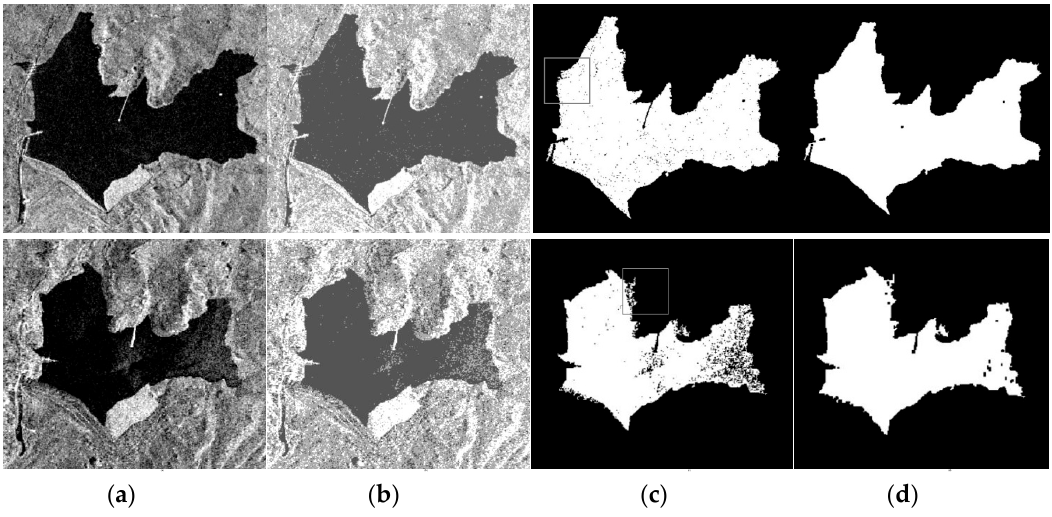
Figure 8. CSK acquired on the 08th of February 2012 during still day (upper panels) and on the 10 September 2012 during windy conditions (lower panels). ( a ) Backscattering σ 0 ; ( b ) unsupervised classification; ( c ) segmented image; ( d ) clumped image.